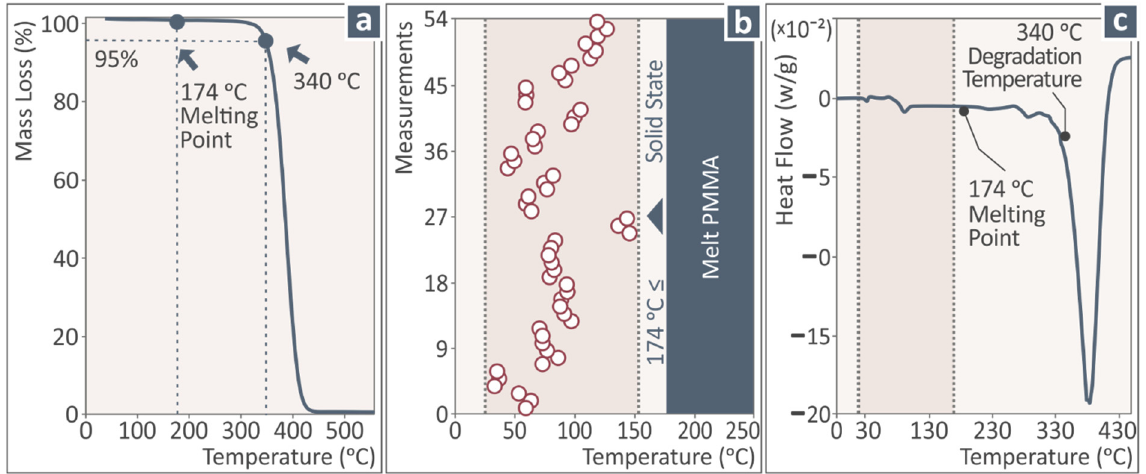
Figure 7. ( a ) TGA graph of the PMMA material; ( b ) maximum temperature values for all of the experiments; ( c ) DSC curves of the PMMA material. Table 2. Input and output parameters.